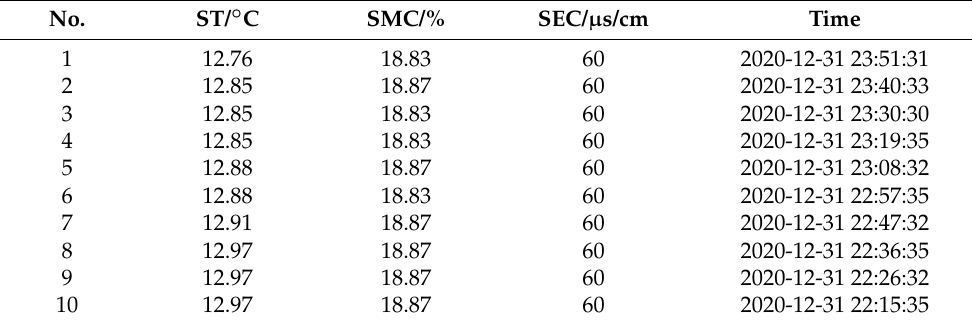
Table 2. Selected data of soil information of tea plantation.